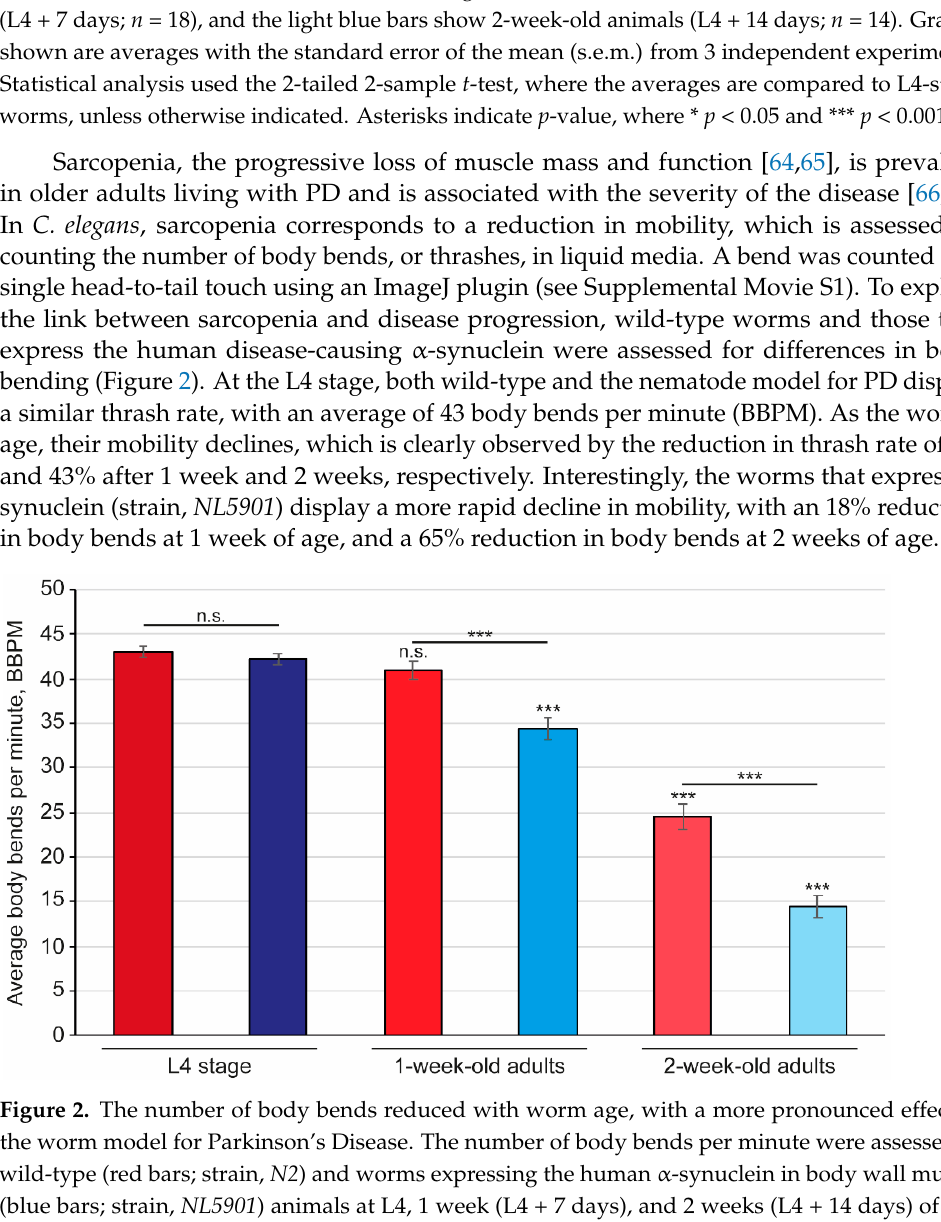
Figure 1. The α -synuclein aggregates display dynamic changes in size and number across the lifespan of C. elegans . ( A ) Representative images of the α -synuclein aggregates. Images are maximal projections from a series of 1 µm Z-stacks taken using a Zeiss Axio LSM 700 from worms at L4 ( i ), 1 week, L4 + 7 days ( ii ), and 2 weeks, L4 + 14 days ( iii ) of age. Images are of independent animals and representative of an n ≥ 14 over a series of 3 independent experiments. The worm strain is NL5901 where α -synuclein is fused to a fluorescent reporter in the body wall muscle. Scale bar, 50 µm. ( B ) Quantification of the number of aggregates and ( C ) size of aggregates. Maximal projections of confocal images were quantified using ImageJ with the number and size (in µm 2 ) of the aggregates assessed. The dark blue bars show the L4 stage ( n = 15), the blue bars show 1-week-old animals (L4 + 7 days; n = 18), and the light blue bars show 2-week-old animals (L4 + 14 days; n = 14). Graphs shown are averages with the standard error of the mean (s.e.m.) from 3 independent experiments. Statistical analysis used the 2-tailed 2-sample t -test, where the averages are compared to L4-stage worms, unless otherwise indicated. Asterisks indicate p -value, where * p < 0.05 and *** p < 0.001.